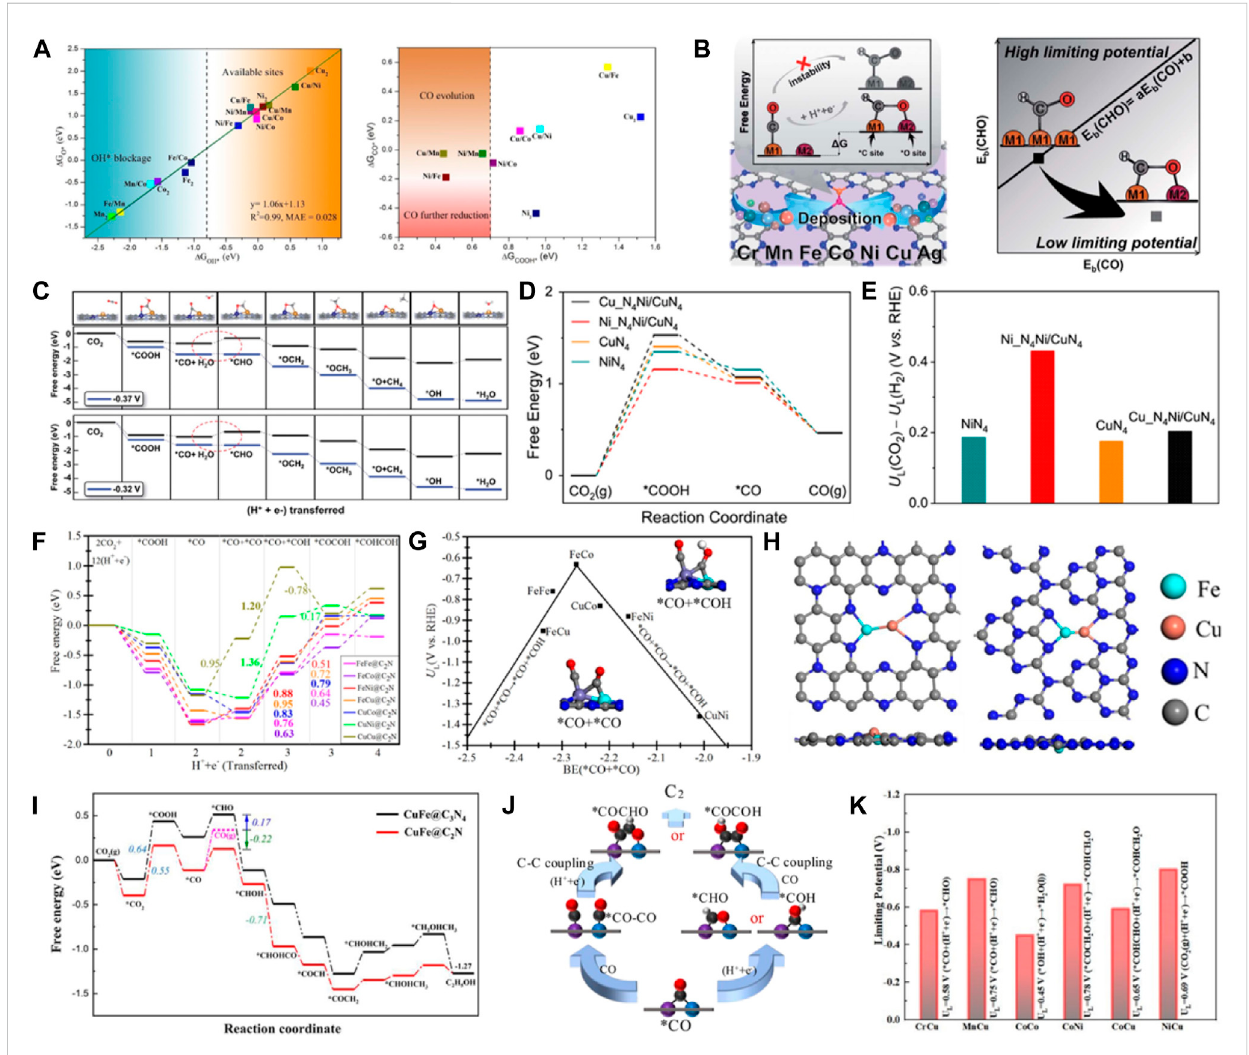
FIGURE 8 (A) Linear diagram of adsorption energy between Δ G OH* and Δ G O* on various DMSCs. COOH* ( Δ GCOOH*) and CO* ( Δ GCO*) on 9 DMSCs. (Figure used with permission from Li etal., 2020). (B) Design ofDACsto reduce freeenergy variation bystabilizing *CHO. (C) Simpli fi edschematic of decoupling the scaling relations between binding energies of *CHO and *CO. ( fi gure used with permission from Wang et al., 2020). (D) Free energy pro fi les of the